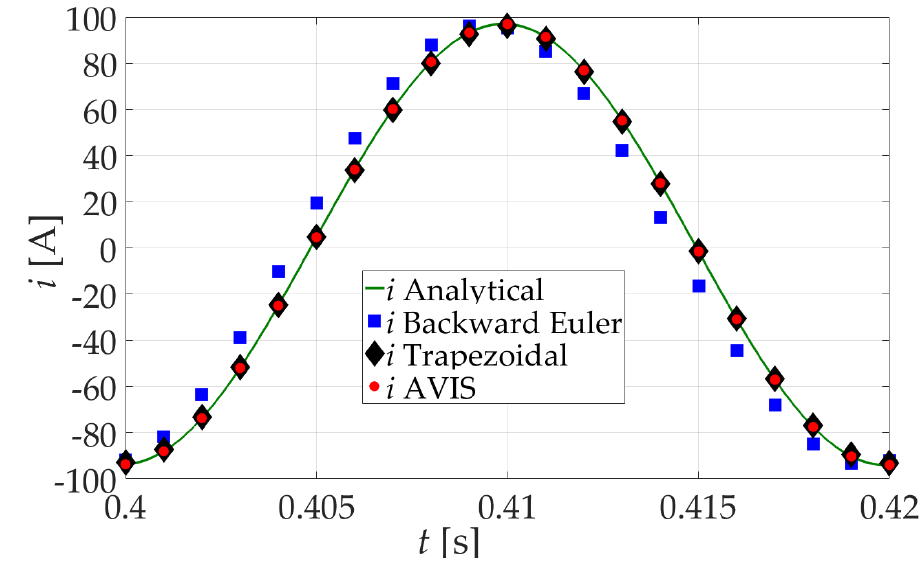
Figure 6. A section of the current waveform after connecting the RL double socket to a voltage source with a frequency of 50